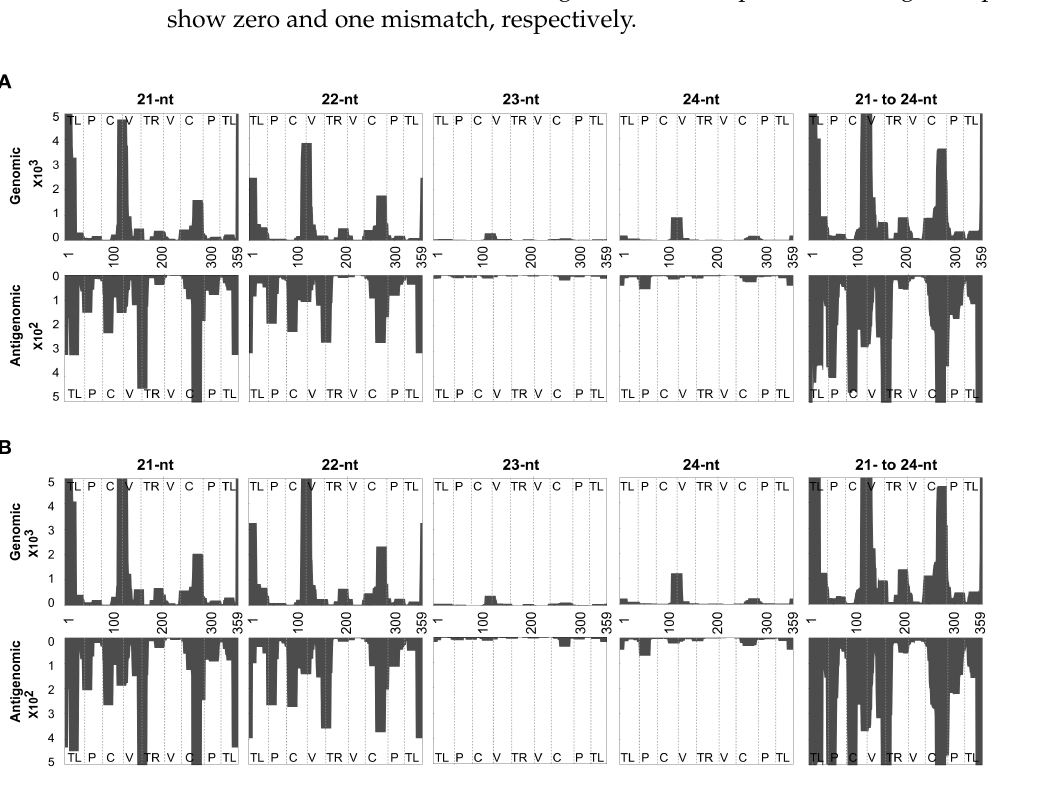
Figure 4. Profiling of the vd-sRNAs recovered from PSTVd-RG1-infected tomato plants at zero and one mismatches. Sequence profiles of the (+) and the ( − ) PSTVd-sRNA populations recovered from the leaf tissues of infected tomato plants. Panels ( A ) represent the profiles of the (+) and the ( − ) PSTVd-RG1-derived sRNAs of zero mismatches of sizes 21-, 22-, 23-, 24-nts and of the cumulative of those of 21- to 24-nts; Panels ( B ) represent the profiles of the (+) and the ( − ) PSTVd-RG1-derived sRNAs of one mismatch of sizes 21-, 22-, 23-, 24-nts and of the cumulative of those of 21- to 24-nts, respectively. The data were normalized to reads per million. In the figure, different structural regions of PSTVd are delimited by dashed lines (from left to right, TL, terminal left; P, pathogenicity; C, central; V, variable; and TR, terminal